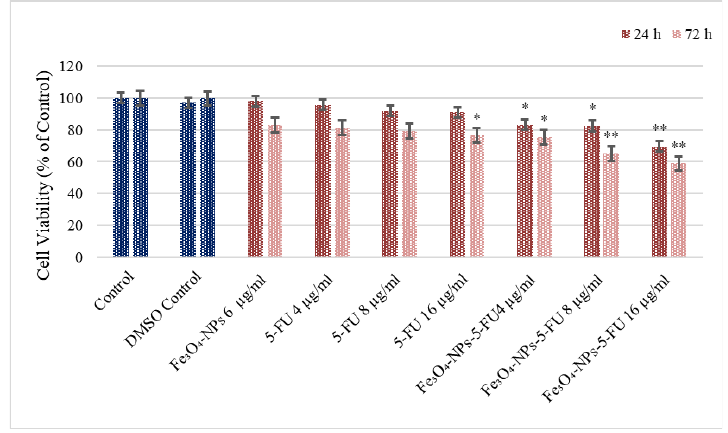
Figure 3. Cell viability was measured with an MTT assay (n = 6). The effect of Fe 3 O 4 0-NPs, 5-FU, and Fe 3 O 4 -NPs + 5-FU on Caco-2 cells’ viability. Cells were cultured in 96-well plates and treated with Fe 3 O 4 -NPs 6 μg/mL, 5 - FU (4, 8, and 16 μg/mL), and the Fe 3 O 4 NPs + 5-FU combination for 24 h and 72 h. The results are presented as the average of three separate experiments. Statistical significance: * p < 0.05; ** p < 0.01.